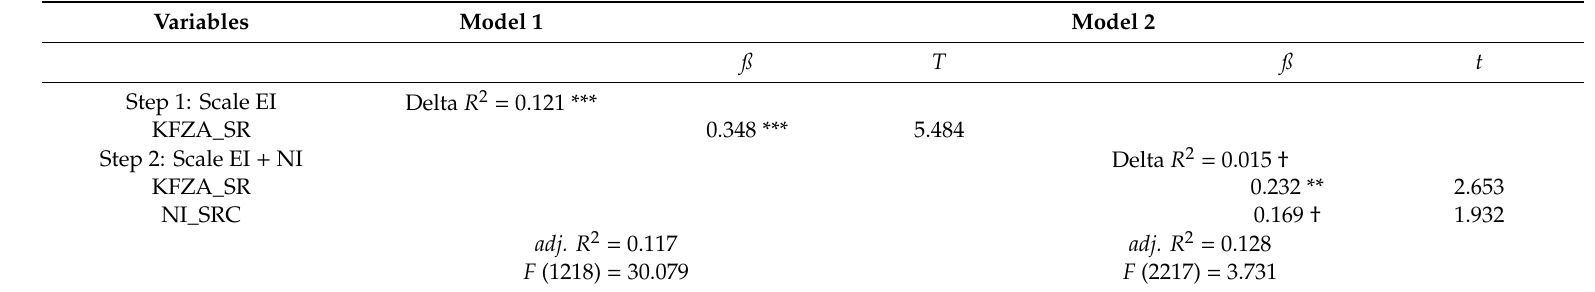
Table A3. Hierarchical regression analyses for the relation between well-being and scales from existing instruments (EI) and the new instrument (NI) assessing social relations (with